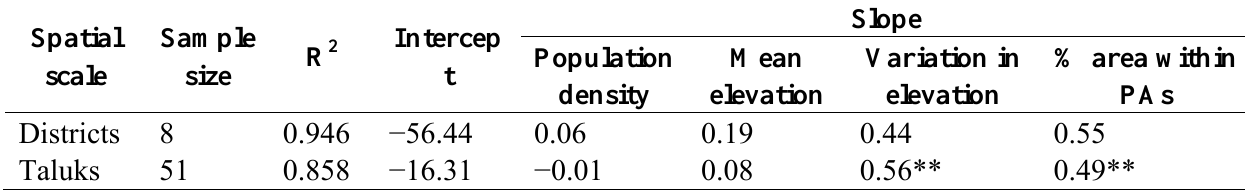
Table 1. Nature, strength and significance of four proposed drivers of forest change—population density, average elevation, variation in elevation and percentage within PAs—on the distribution of stable forest in the study region, at the scale of districts and taluks. Results based on a linear multiple regression analysis. Significance codes: ** p < 0.01, * p < 0.05.